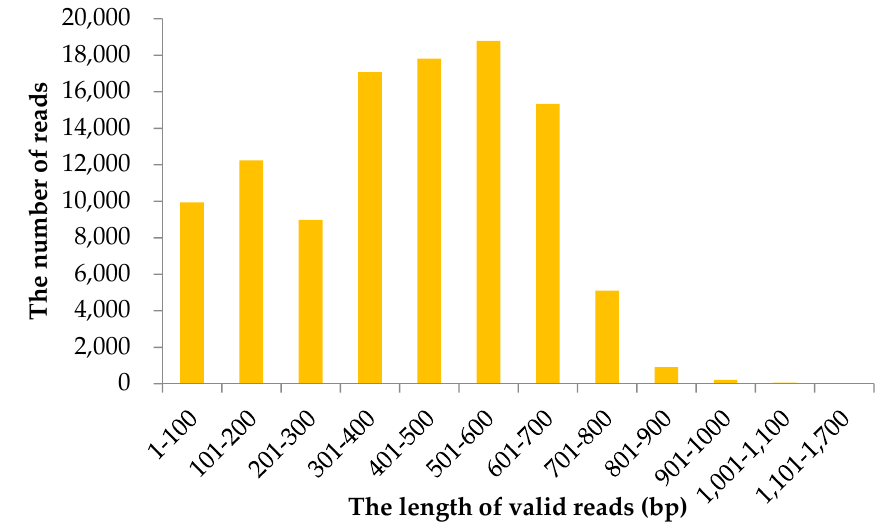
Figure 1. Length distribution of valid reads sequenced on GS FLX plus platform for Betula alnoides .